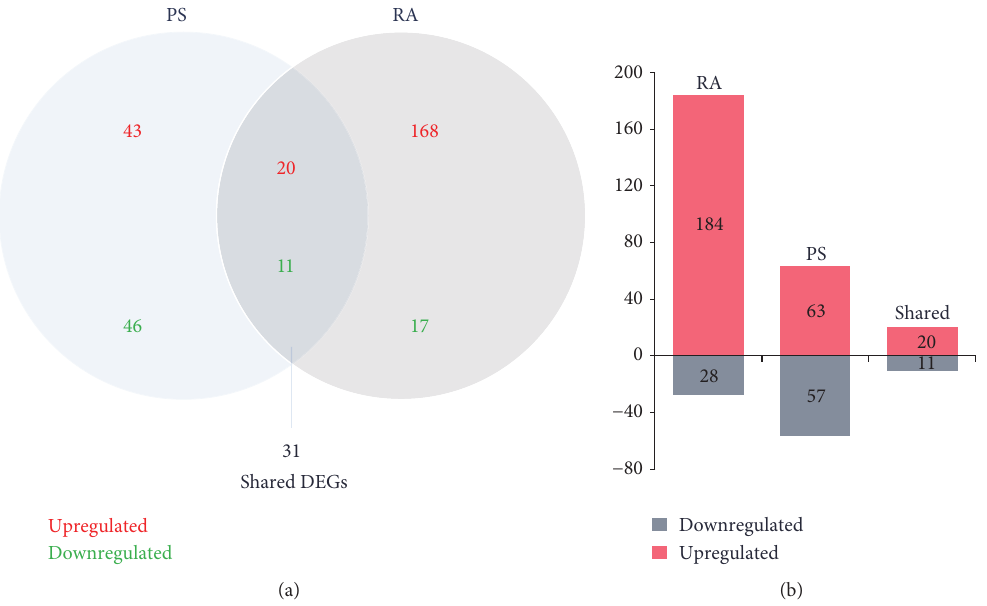
Figure 1: Number of DEGs in PS and RA. (a) The Venn diagram indicates the number of uniquely upregulated (red) or downregulated (green) genes from the comparisons of PS and RA with control and the number of shared DEGs. (b) The bar diagram shows the number of DEGs in PS, RA, and the shared DEGs between them.